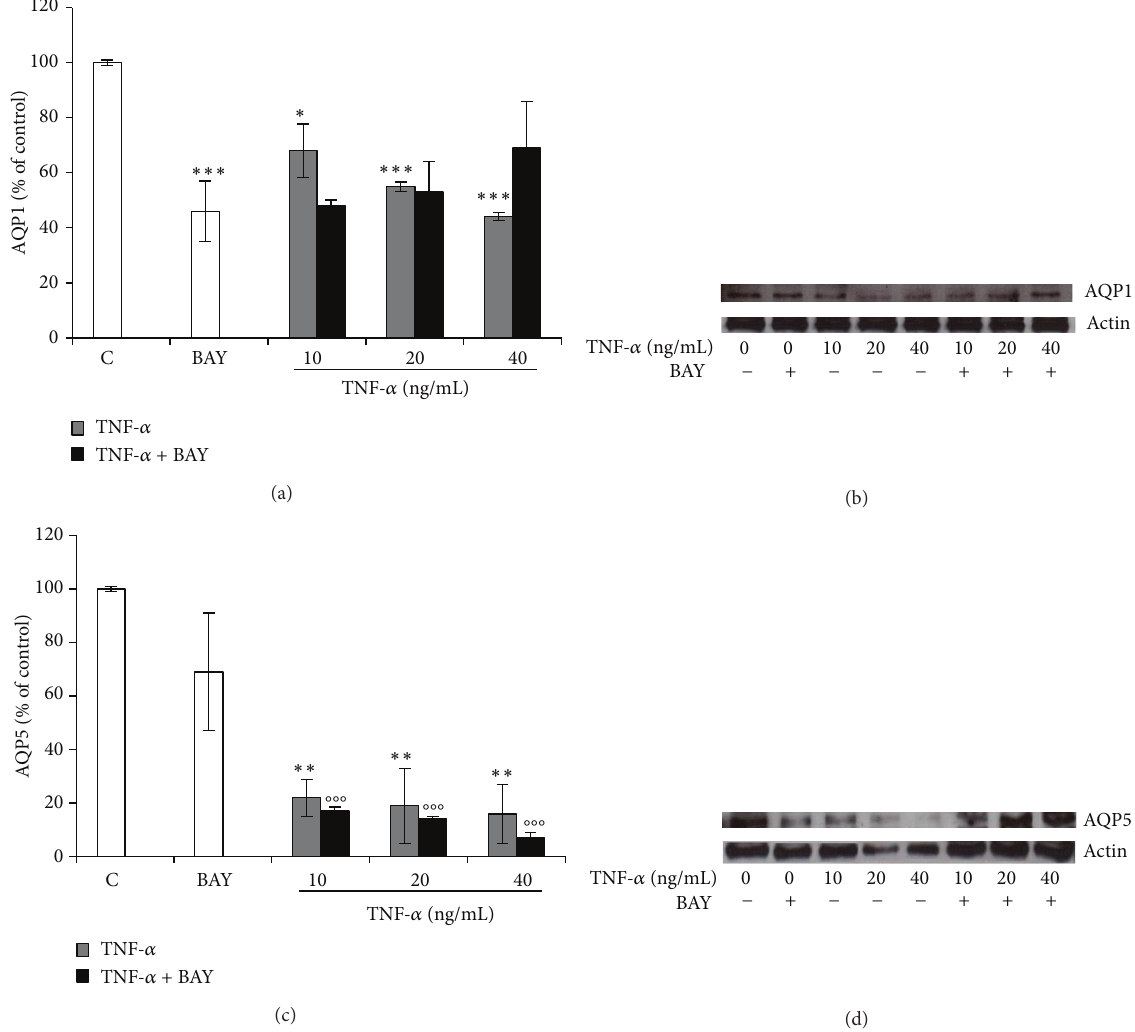
Figure 7: TNF- 𝛼 downregulation of AQP1 and AQP5 expression may require activation of NF- 𝜅 B pathway.BEAS-2B cells were treated with 10, 20, and 40 ng/mL TNF- 𝛼 alone or in combination with NF- 𝜅 B inhibitor BAY 11-7082 (1 𝜇 M), for 24 h. Gene expression of AQP1 ((a), (b)) and AQP5 ((c), (d)) at mRNA ((a), (c)) and protein ((b), (d)) level. Western blots were obtained by using the specific rabbit polyclonal Abs. The blots were stripped of the bound Ab and reprobed with mouse anti- 𝛽 -actin, to confirm equal loading. Western blots are representative of three separate experiments. All histograms indicate means ± SD of three different cultures each one tested in quadruplicate and expressed as percentage of control ( ∗ 𝑃 < 0.01 , ∗∗ 𝑃 < 0.001 , ∗∗∗ 𝑃 < 0.0001 versus Controls; and ∘∘∘ 𝑃 < 0.0001 versus BAY). C: Controls (untreated